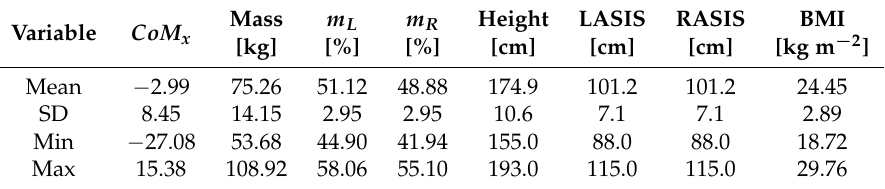
Table 3. Experiment 1: Measurement results of the CoM along the x -axis ( CoM x ), mass, loads on the left ( m L ) and right ( m R ) legs, the positions of the LASIS and RASIS anatomical points, and the BMI. The loads on the left and right legs are shown as percentages [%] of the human body